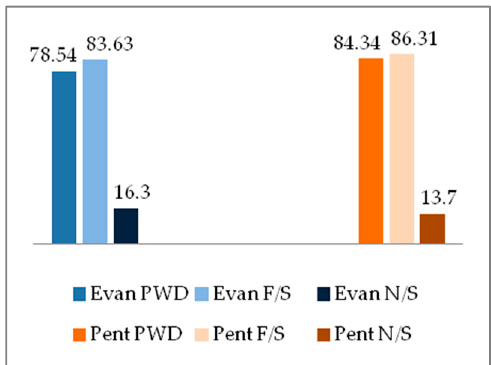
Figure 6. Theological Beliefs Overall Average % Denominational Shift